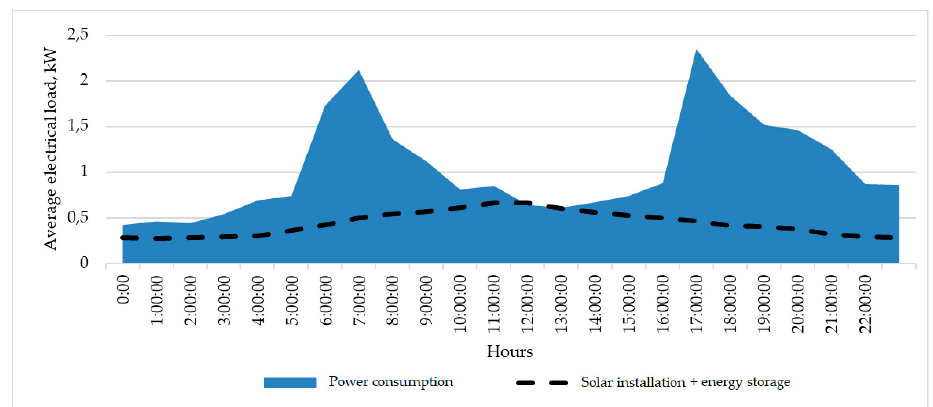
Figure 6. Household electrical load graph on a day off with a superimposed graph of electricity generated by solar installations.